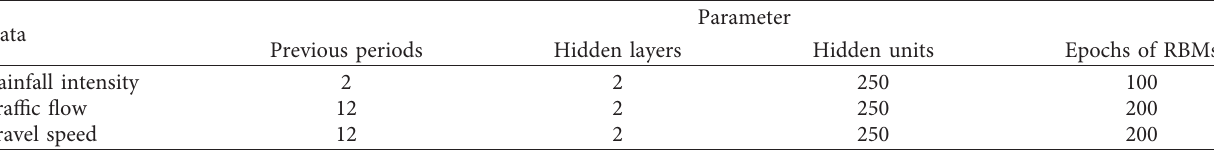
Table 1: The best architecture for DBN with different input